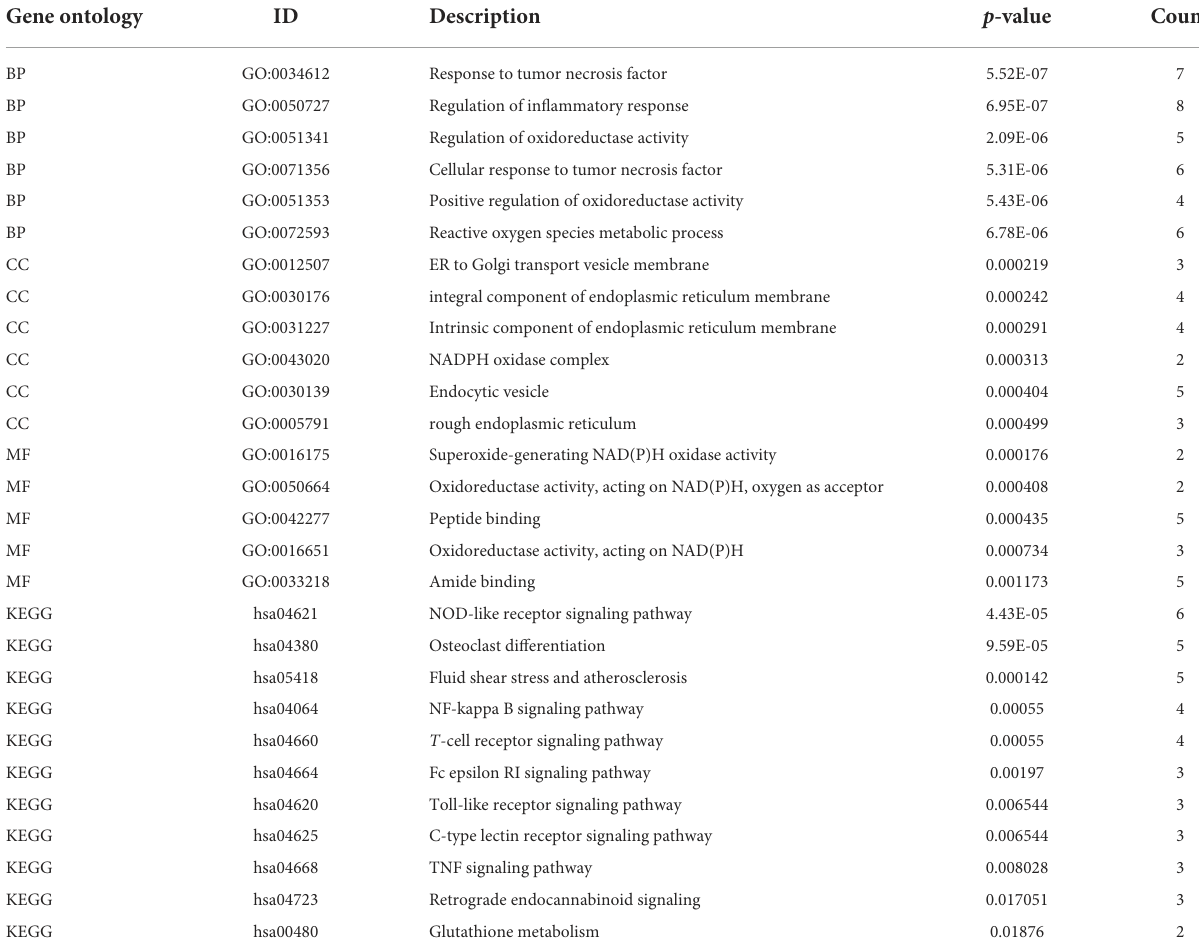
TABLE 2 The details of GO and KEGG terms for ERSR-DEGs with their corresponding p -values. Gene